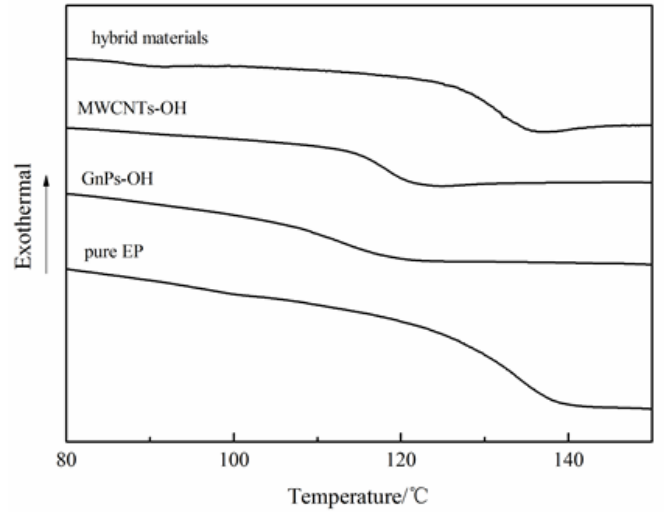
Figure 4. The glass transition temperature ( T g ) curves of pure epoxy and epoxy composites with different fillers.